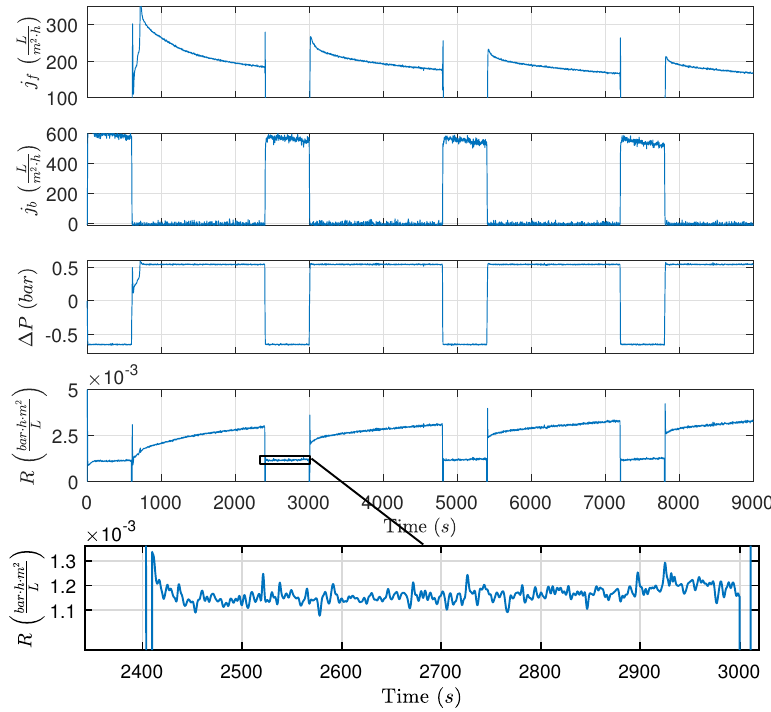
Figure 4. Highlighting resistance for both the filtration and backwashing phase. Experimental conditions: t f = 1800 s, t b = 600 s, Q cf , ref = 1 m , ∆ P f , ref = 0.5 bar, and ∆ P b , ref = − 0.6 bar, where the s subscript ref denotes the control reference for the given variable, and Q cf is the